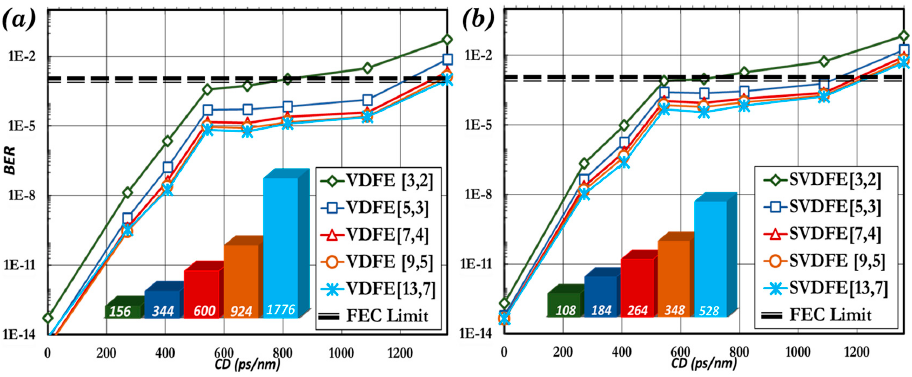
Figure 6. Performance of ( a ) VDFE; ( b ) SVDFE, and the number of coefficients for each case.